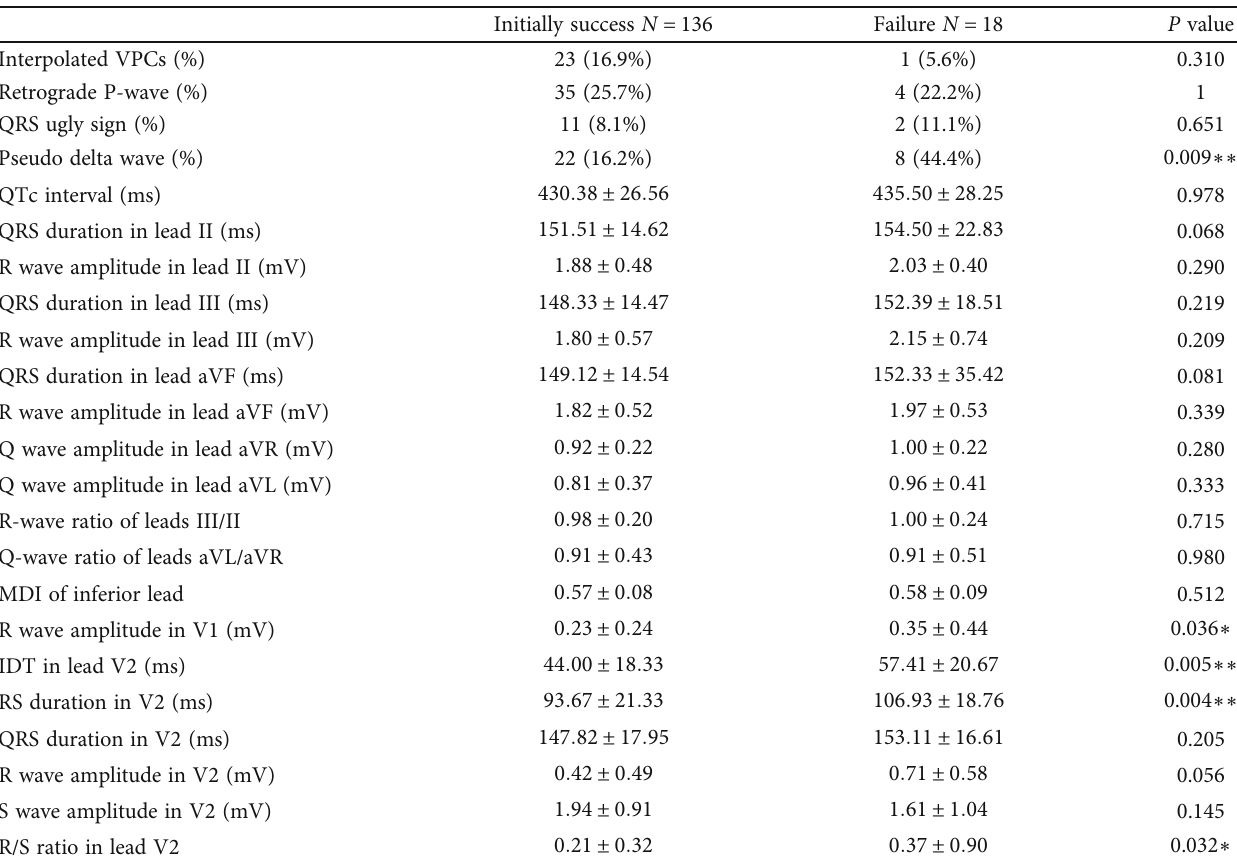
Table 3: Comparison of ECG parameters in patients with initially successful and failed RFCA ( N = 154 ).